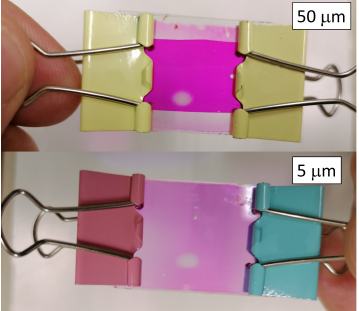
Figure 2. Typical thick and thin samples recorded with the setup reported in Figure